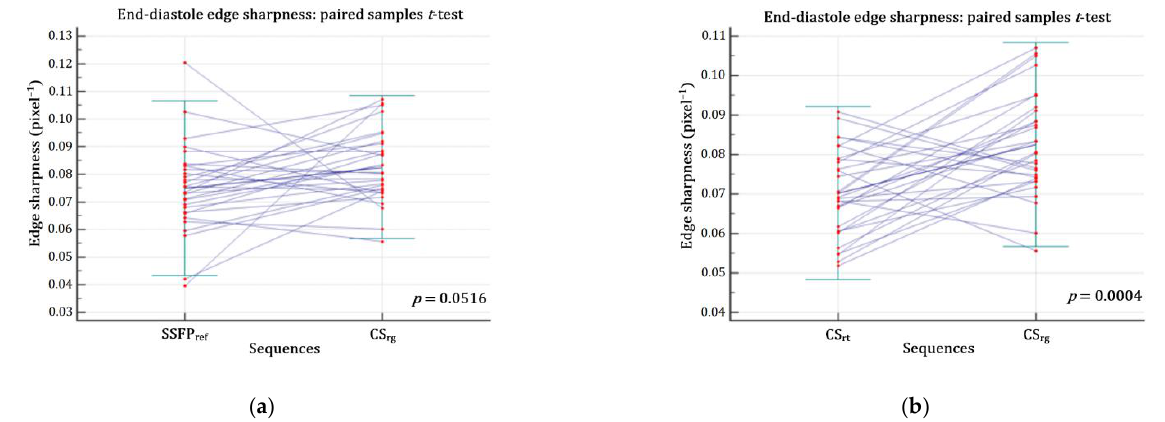
Figure 3. Edge sharpness comparison assessed at end-diastole. ( a ) There was no significant difference regarding ε between CS rg and SSFP ref ( p = 0.0516) ( b ) but CS rg significantly improved ε while compared with CS rt ( p = 0.0004). Abbreviations: CS rg , retrogated compressed sensing; CS rt , real-time compressed sensing; SSFP ref , reference steady-state free precession; ε, edge sharpness.